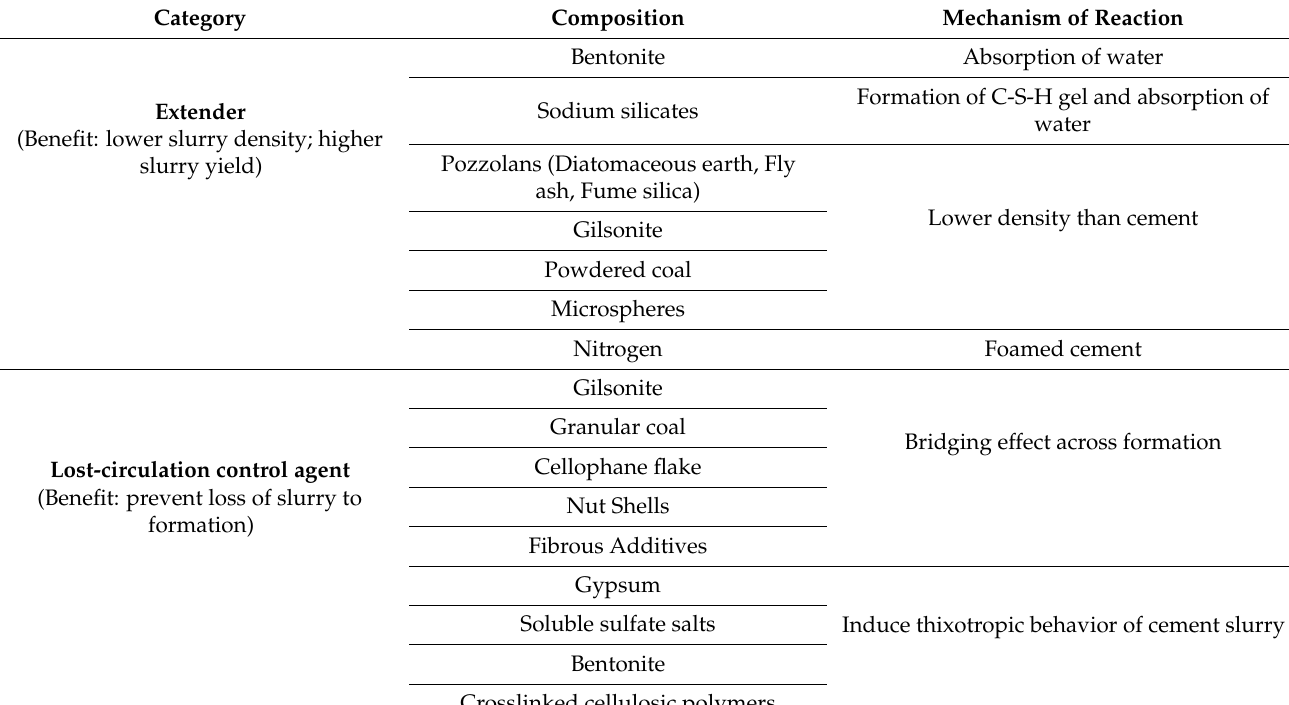
Table 6. Cement slurry additives—extenders and lost circulation control agent modified to [44]. Category Composition Mechanism of Reaction